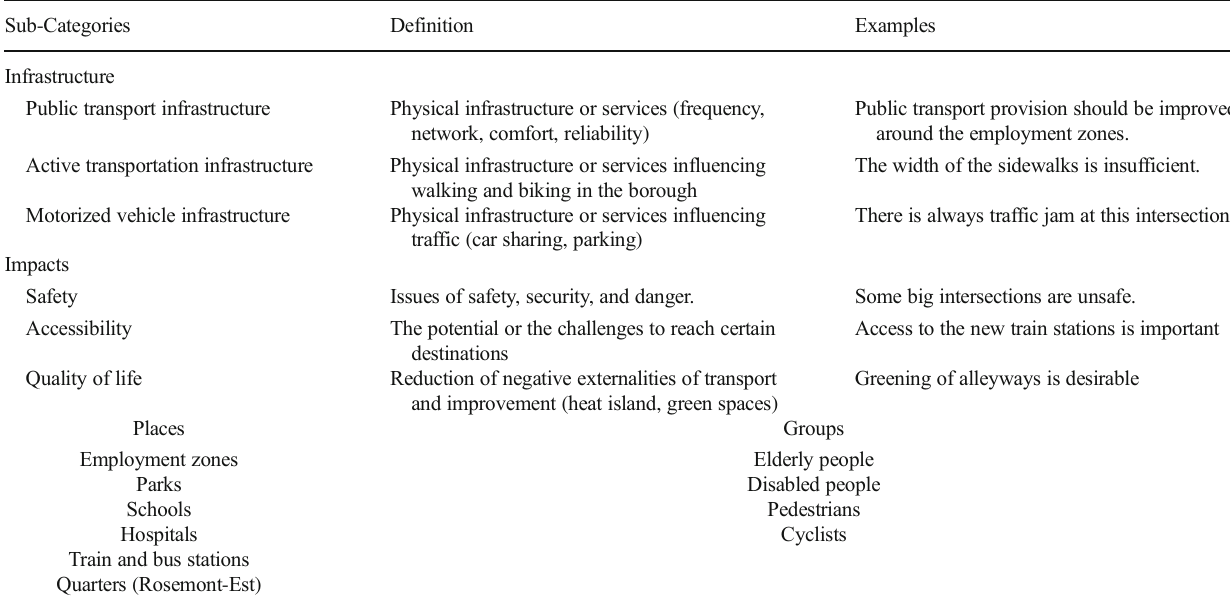
Categories emerging from the document analysis of the reports of the participatory processes. The predominant categories are the transportation infrastructure and the impacts of transport. Examples of comments from the reports are included to illustrate the sub-categories